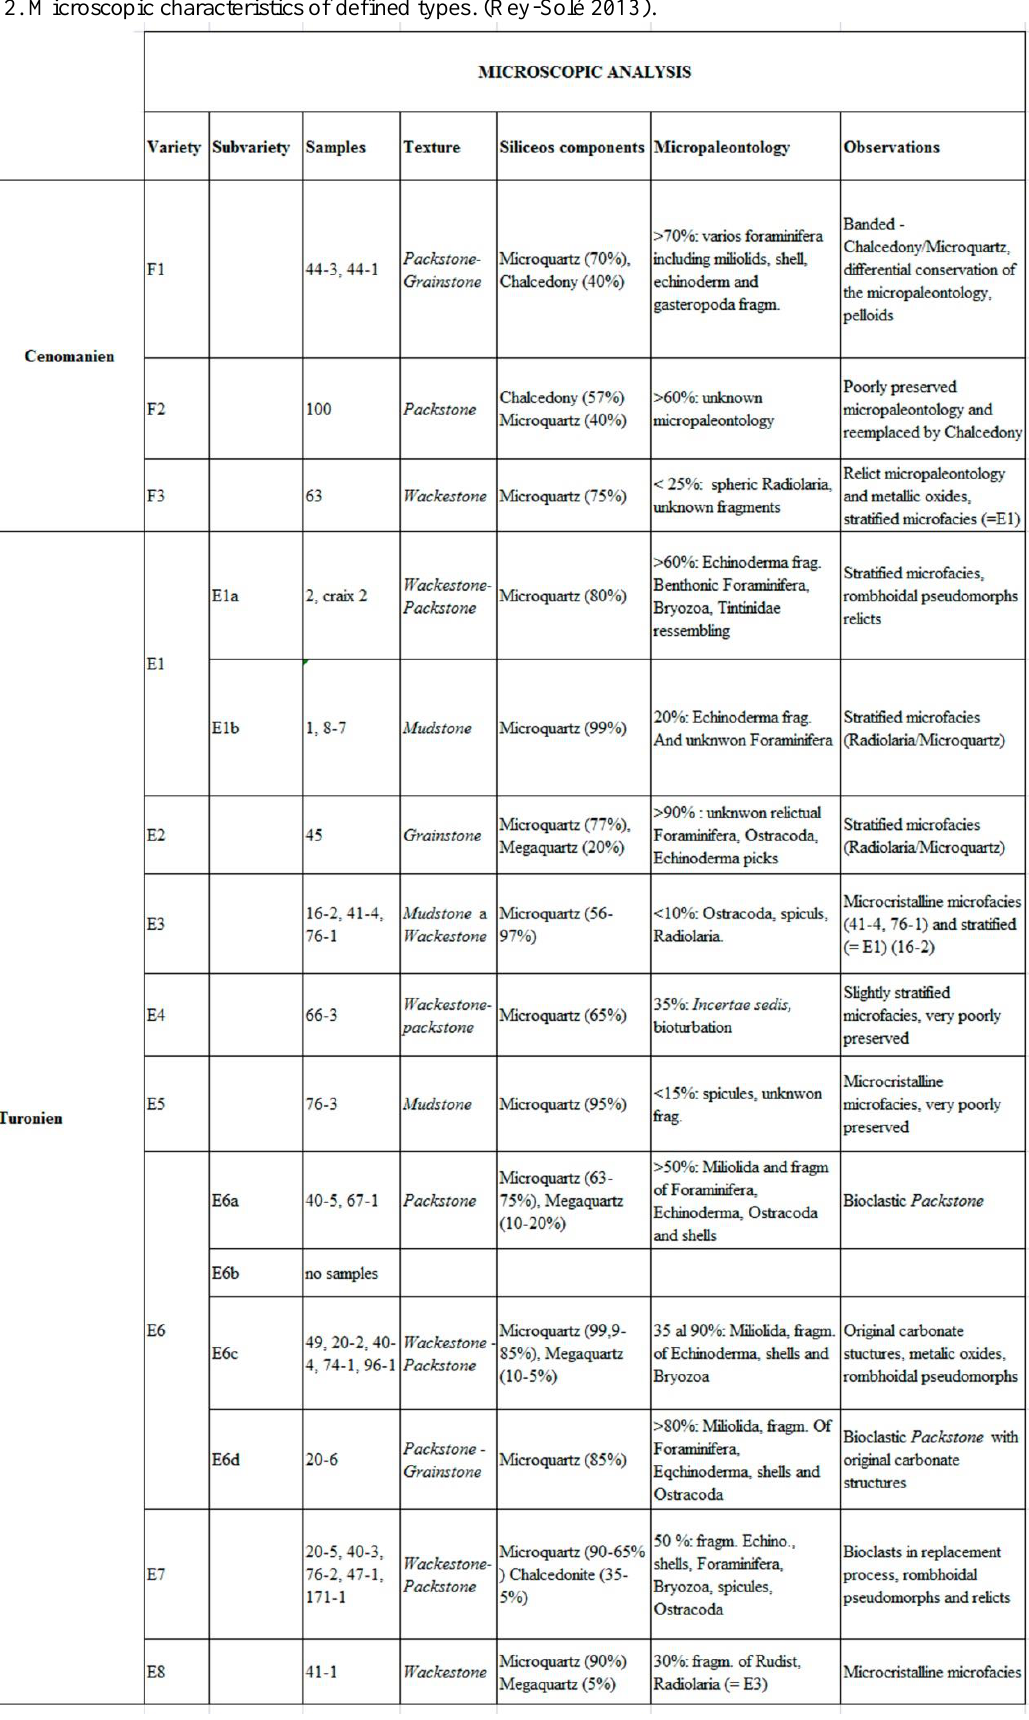
Table 2. Microscopic characteristics of defined types. (Rey-Solé